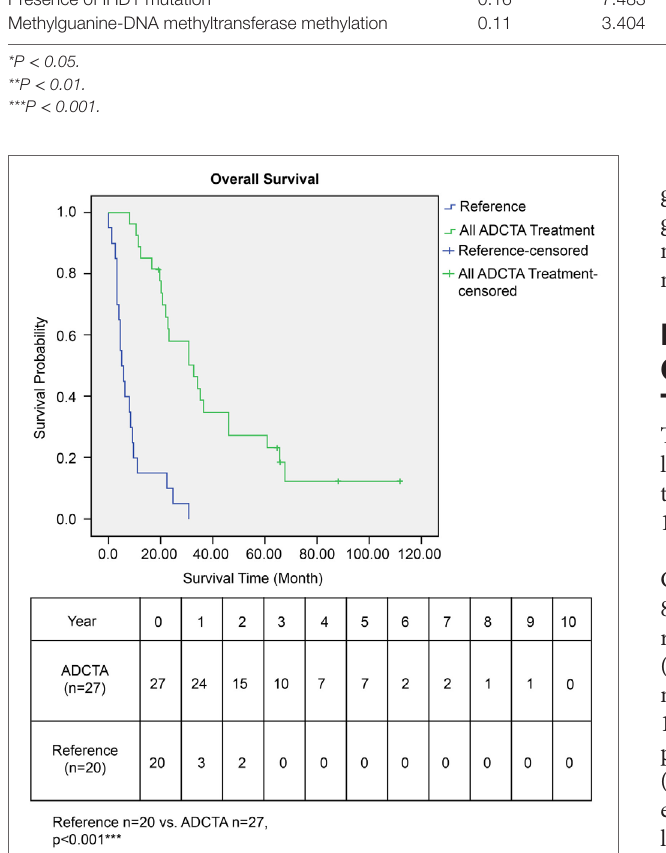
FigUre 4 | Overall survival (OS) in ADCTA versus reference group glioblastoma patients. Kaplan–Meier survival plots of the OS of 27 ADCTA patients compared to 20 reference patients.